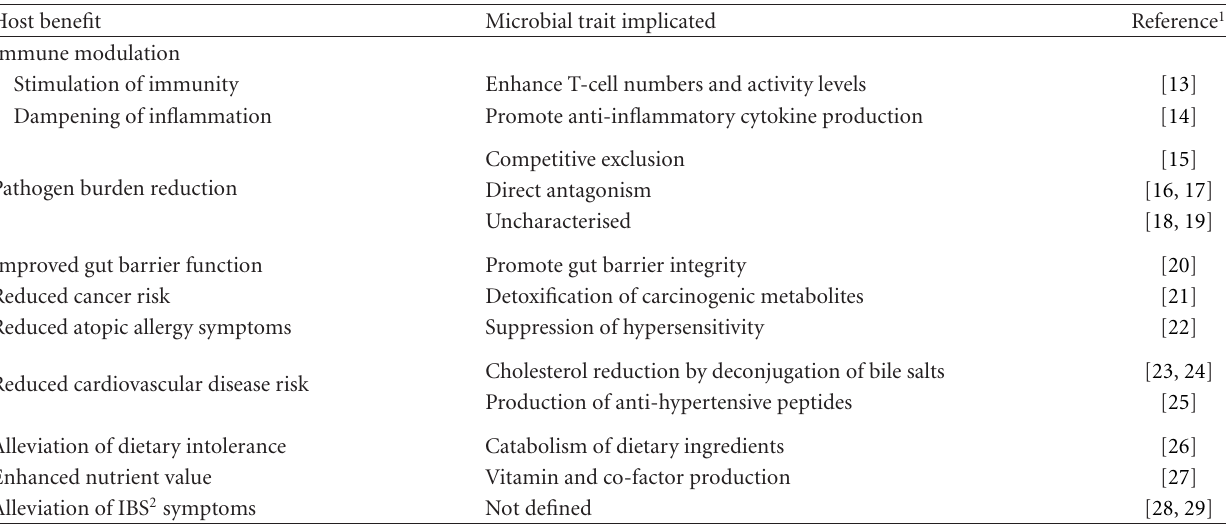
Table 1: Beneficial properties reported for probiotic